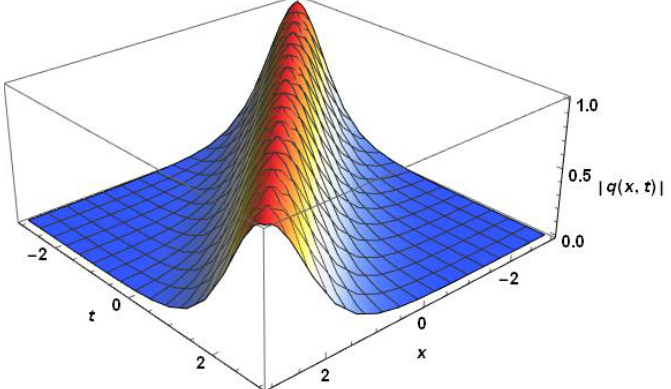
Figure 2. Profile of the HD bright 1 – soliton (56) setting all arbitrary parameters to unity.